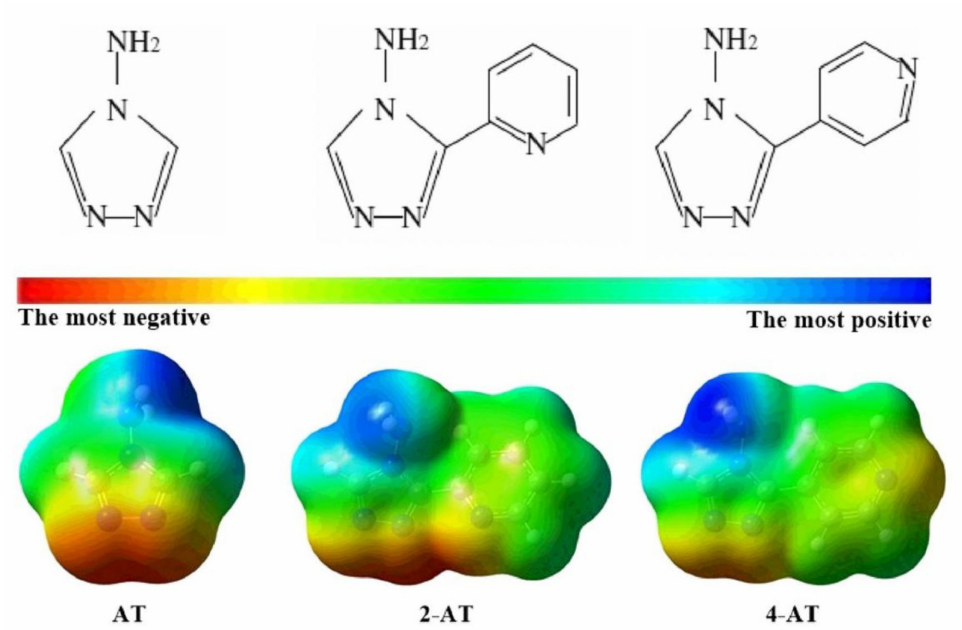
Figure 4. MEP maps of the three inhibitors (2-amino-1,3,4-triazole (AT), 3-(2-pyridyl)-2-amino-1,3, 4-triazole (2-AT) and 3-(4-pyridyl)-2-amino-1,3,4-triazole (4-AT)) calculated by B3LYP/6-311 + (2d,p) level. (Reprinted with permission from Ref. [113]. Copyright 2016 Elsevier